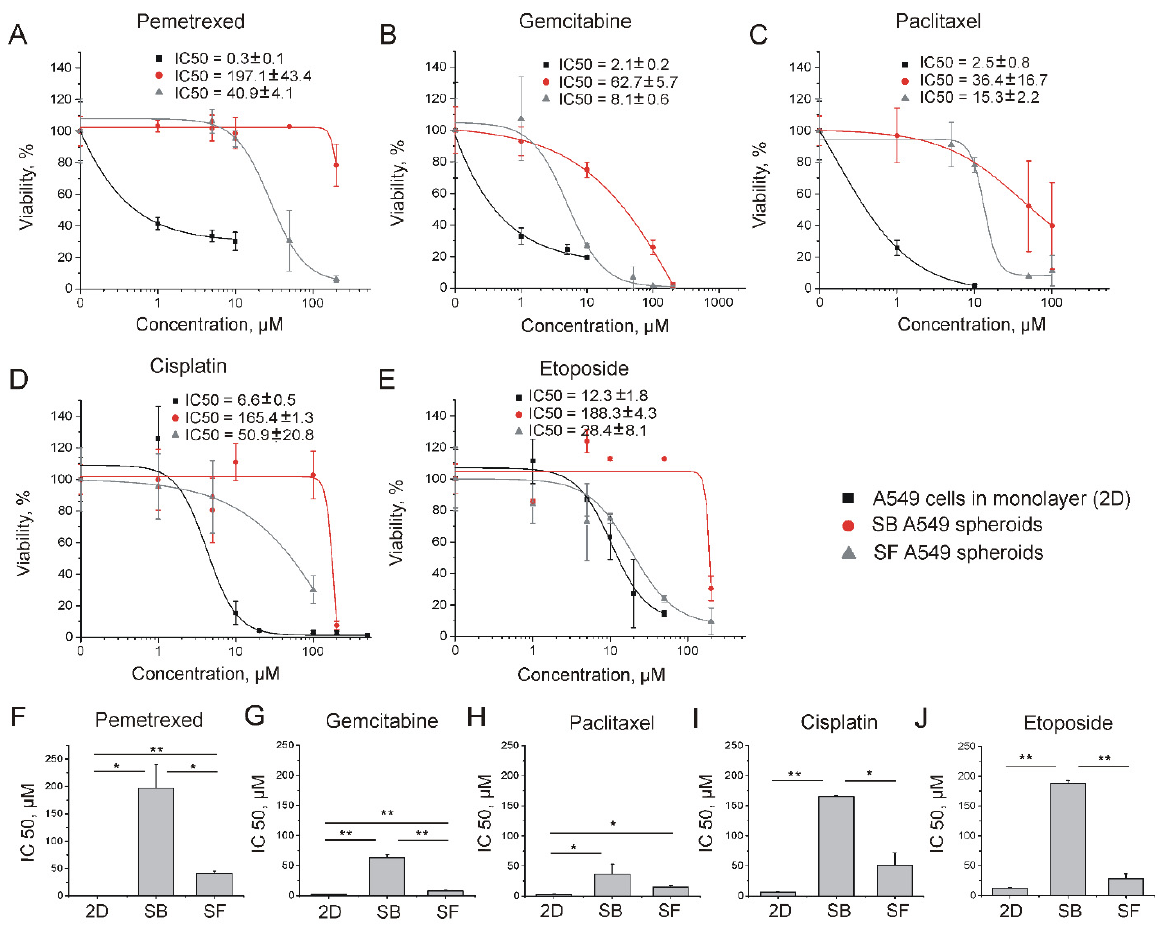
Figure 3. Analysis of drug resistance of different A549 cell cultures. Survival curves of A549 cells in monolayer culture (2D), SF and SB spheroids after 72 h of incubation with pemetrexed ( A ), gemcitabine ( B ), paclitaxel ( C ), cisplatin ( D ), and etoposide ( E ). Data are shown as means ± SD. Evaluation of IC 50 values of ML A549 cells, SF and SB A549 spheroids after exposure to pemetrexed ( F ), gemcitabine ( G ), paclitaxel ( H ), cisplatin ( I ), and etoposide ( J ). Data are shown as means ± SD ( n = 3). * p < 0.05, ** p < 0.01 (Mann–Whitney U test).